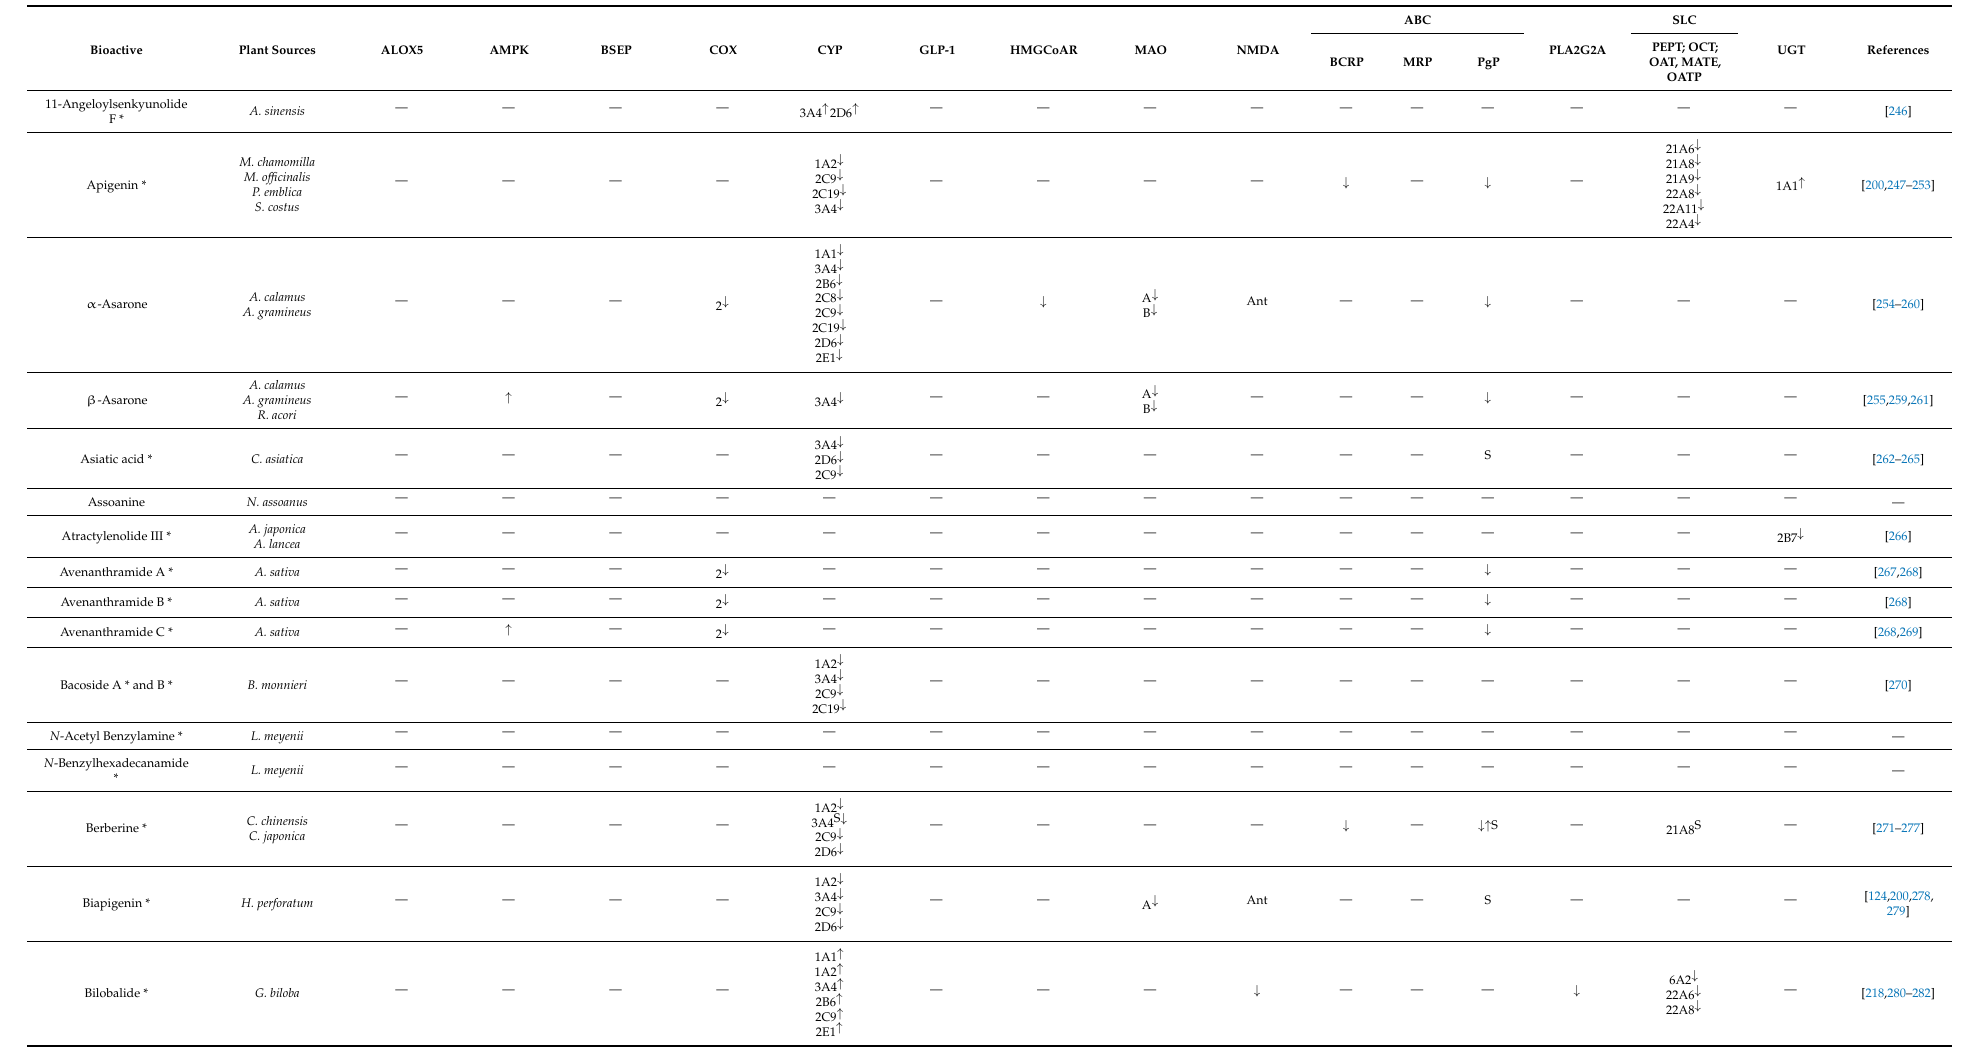
Table 3. Characterization of the identified phytochemicals in terms of origin and main enzymatic targets (substrates, inhibitors, and